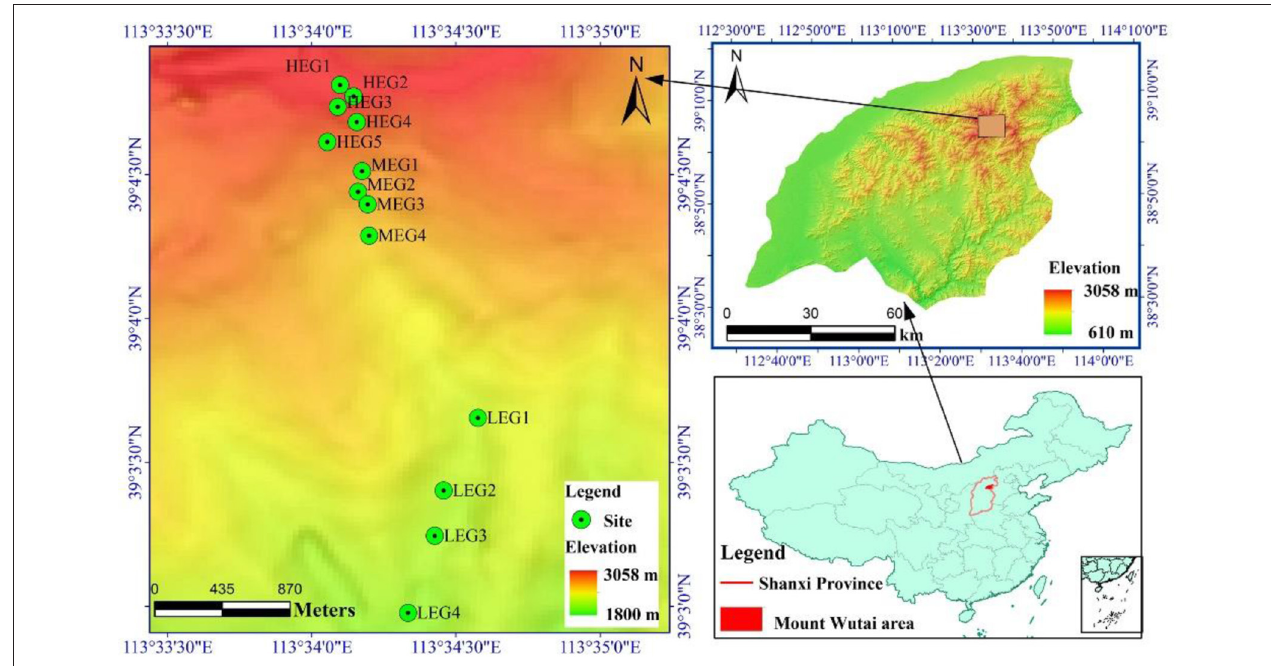
FIGURE 1 | Map showing the location of Mount Wutai and the sampling sites. High elevational gradient (HEG) (2900–3055m) including five different elevation sampling sites (HEG1, HEG2, HEG3, HEG4, and HEG5), both medium elevational gradient (MEG) (2500–2800m) (MEG1, MEG2, MEG3, and MEG4) and low elevational gradients (LEG) (2000–2300m) (LEG1, LEG2, LEG3, and LEG4) including four different elevation sampling